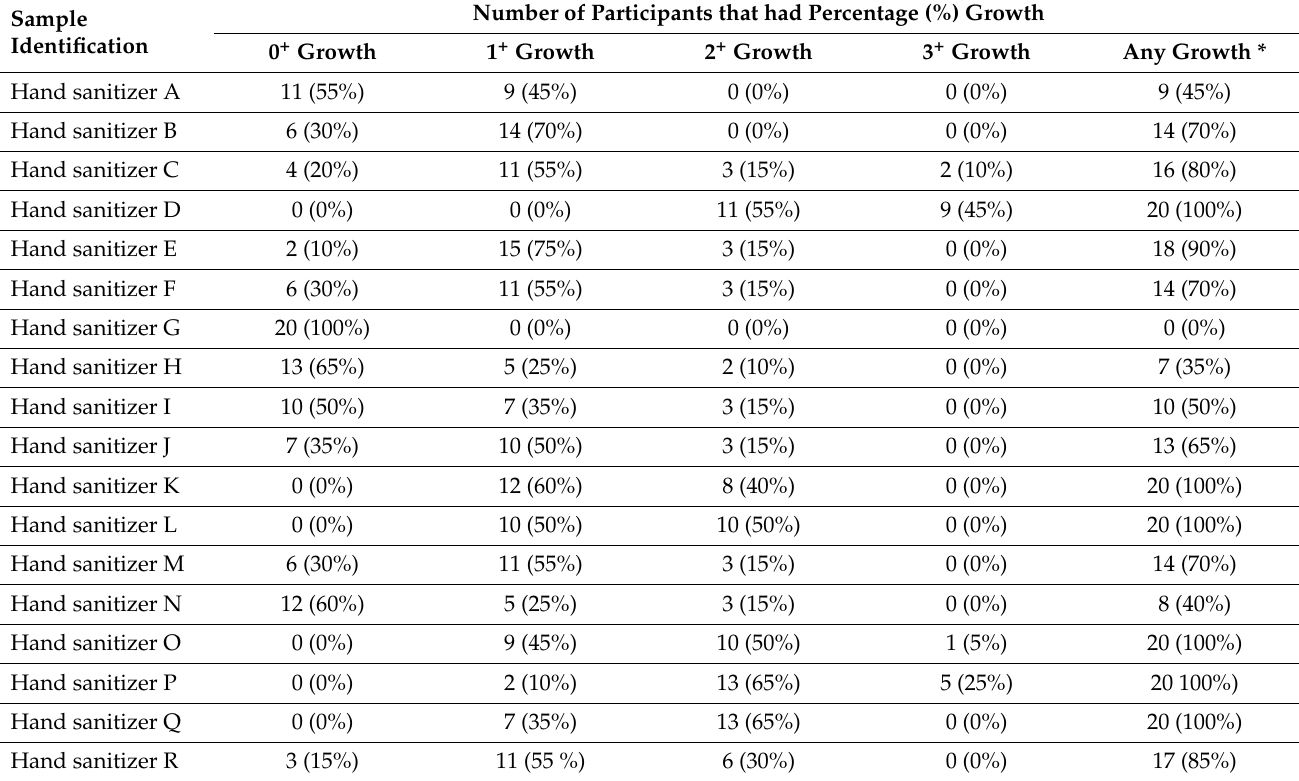
Table 1. Percentage of microbial growth pre- and post-hand sanitizer application by laboratory workers.